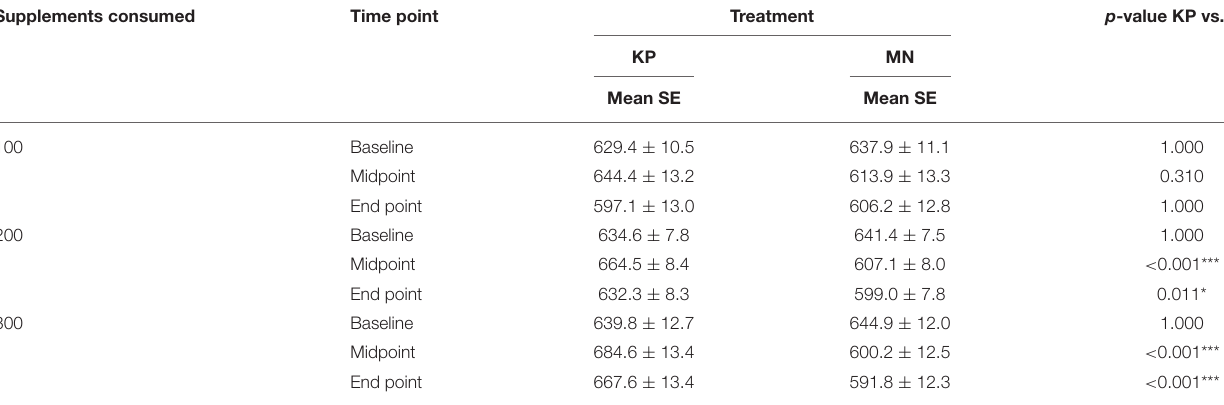
TABLE 4 | Estimated plasma EAA concentration in different number of supplements consumed. Supplements consumed Time